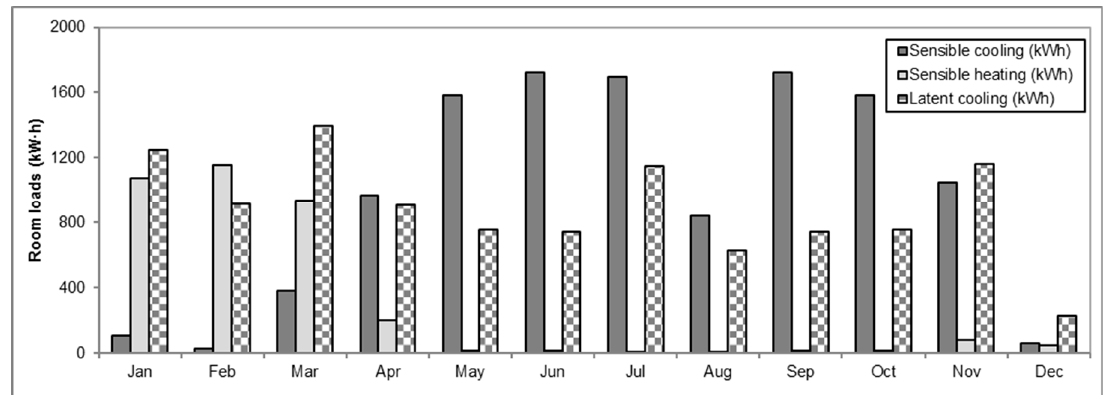
Figure 5. Monthly internal loads.